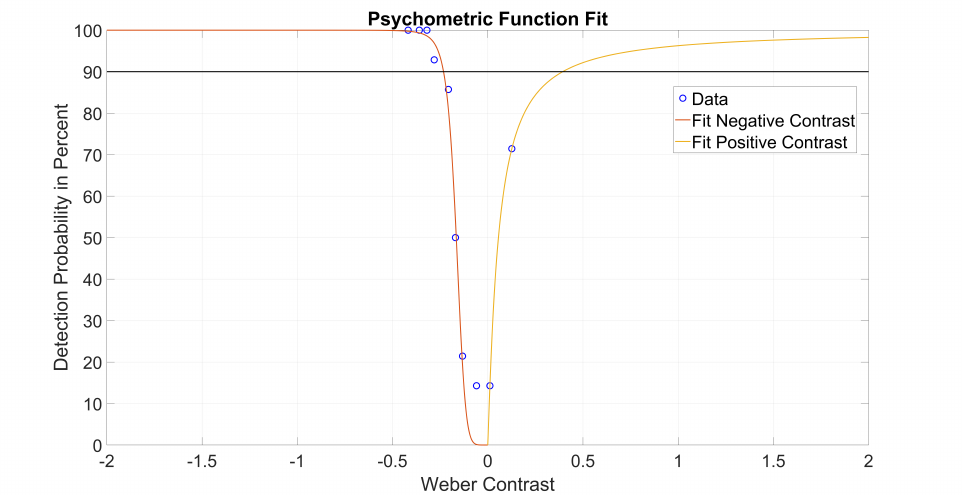
Figure 5. Example of data evaluation using the psychometric function acoording to Linschoten